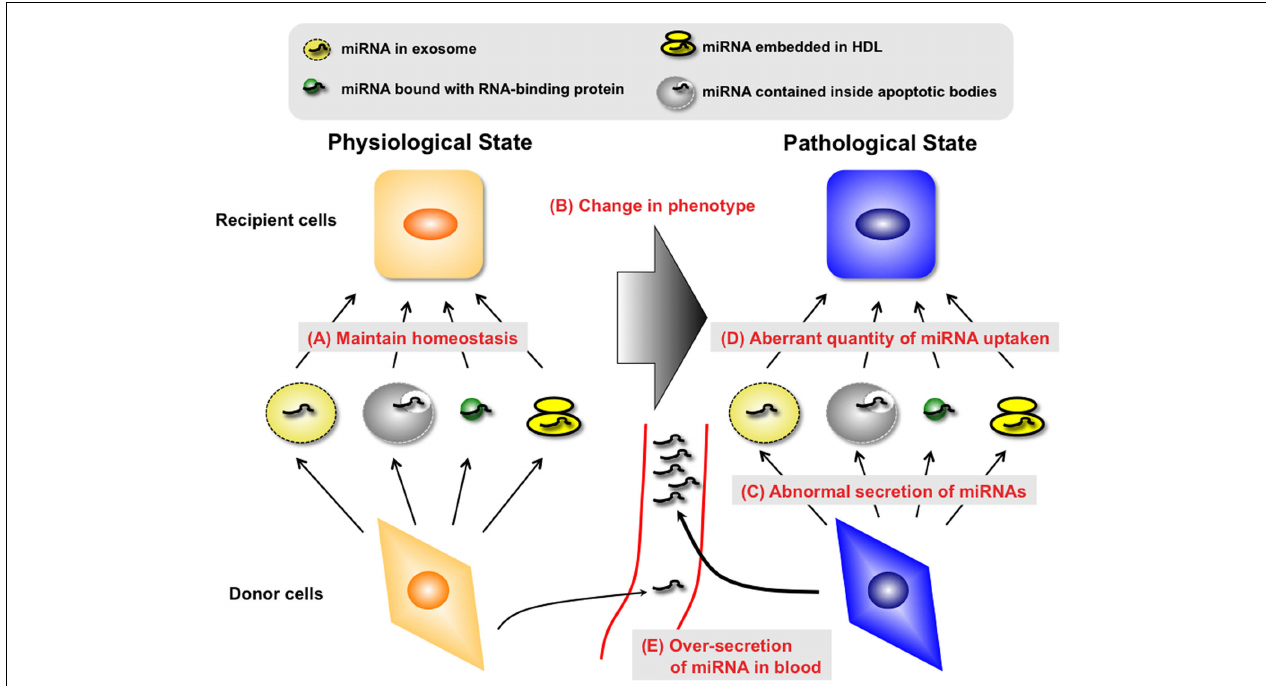
miRNA species with carriers (C) . Furthermore, the quantity of secretory miRNA uptake by recipient cells may change in this situation (D) . It is necessary to understand these abnormal changes of molecular mechanisms for the development of a therapy against “secretory miRNAs-mediated diseases.” In addition, it is possible that the amount of secretory miRNAs changes in this situation through the abnormal regulation of carrier production (E) . Understanding these changes may lead to the exploitation of a diagnosis marker for “secretory miRNAs-mediated